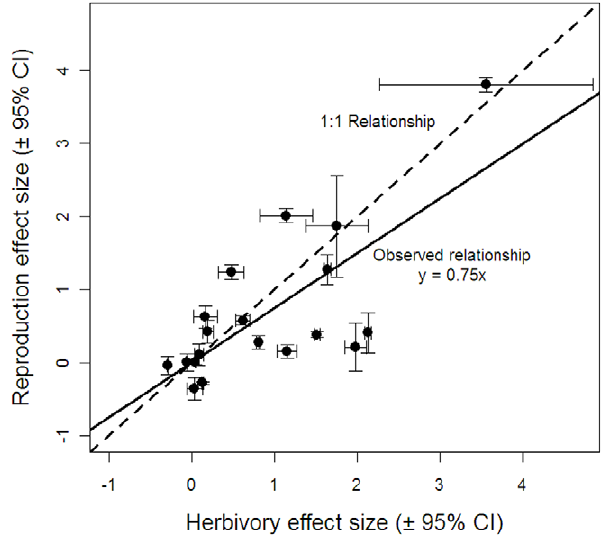
Figure 2. Relationship between the effect sizes for herbivory and reproductive output. Means ( 6 95% CI) for both effect sizes are presented for the 19 studies that contained data on both herbivore damage and reproductive output. The dashed line indicates a hypothetical 1:1 relationship; the solid line indicates the observed relationship (see Equation 5 for weighted correlation procedure). The slope of the relationship was significantly less than 1 (Maximum Likelihood Estimate =0.75, 95% CI =0.71 to 0.79).